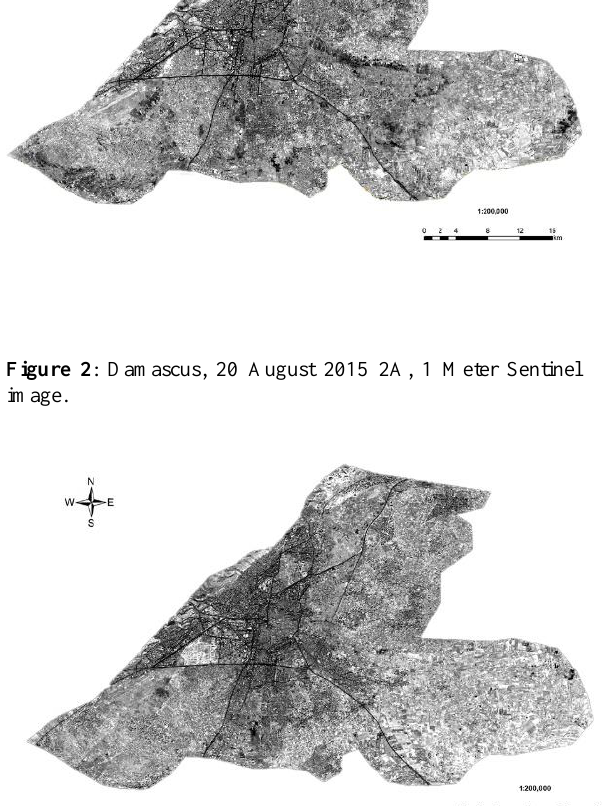
Figure 3 : Damascus, 27 October 2020 2A, 1 Meter Sentinel